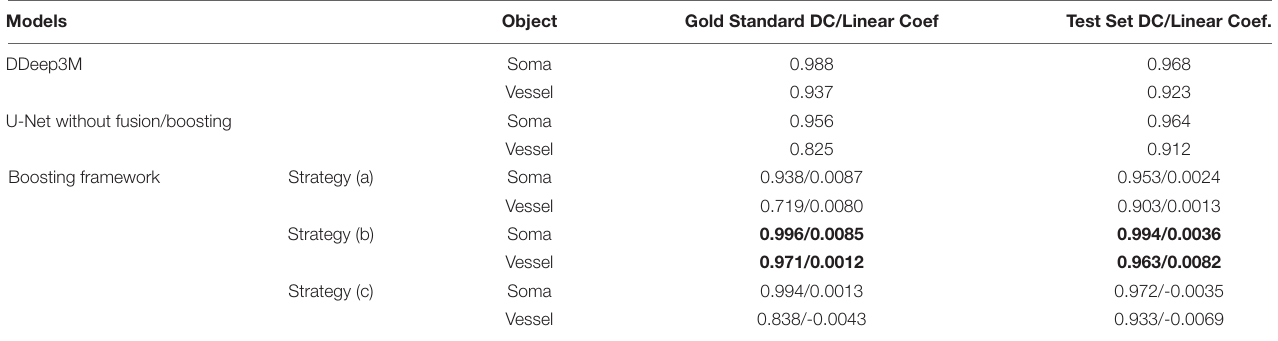
TABLE 1 | Network performance (mean DC) and performance boosting trend (linear coef.) of the proposed framework. Models Object Gold Standard DC/Linear Coef Test Set DC/Linear Coef.